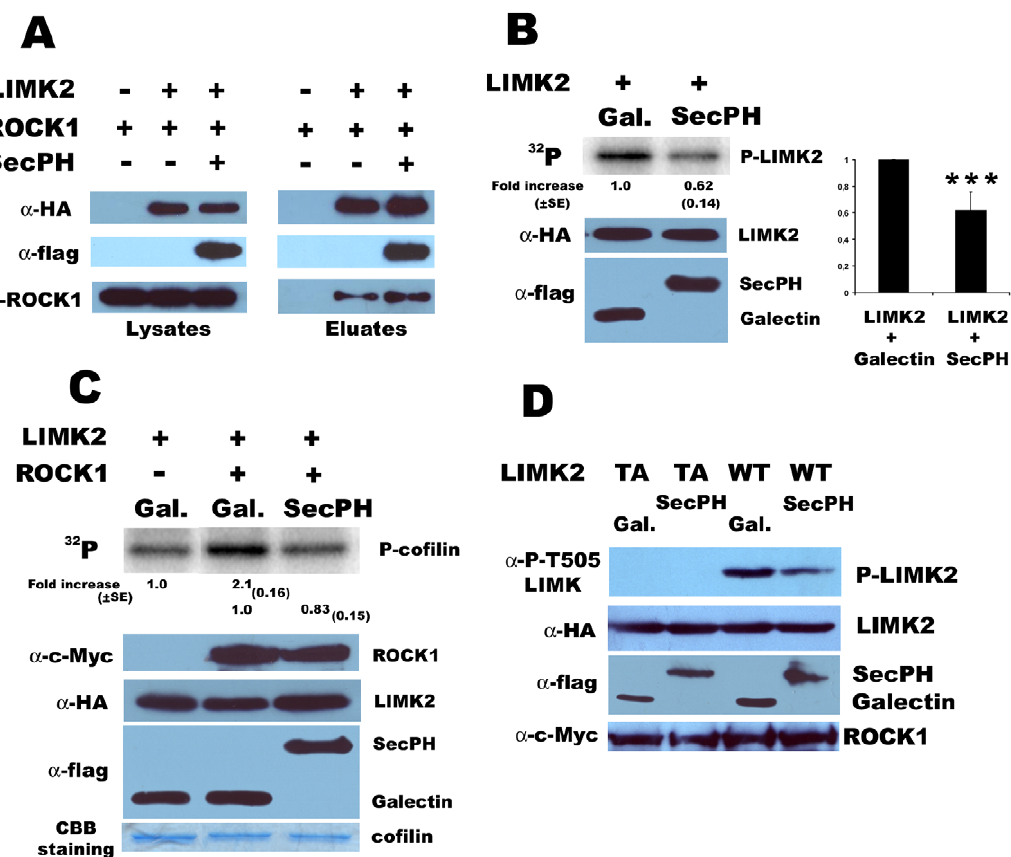
Figure 4. Mechanism of SecPH inhibition of LIMK2 kinase activity. A. SecPH does not prevent LIMK2 from interacting with ROCK1 . Cells were cotransfected with HA-LIMK2, ROCK1 and SecPH or its empty parental plasmid. Lysates and anti-HA immunoprecipitates were subjected to immunoblotting. B. SecPH affects LIMK2 phosphorylation. Same as Figure 2B. Statistical significance was determined relative to control using one-way ANOVA (*** p , 0.0001). C. Inhibition of LIMK2 cofilin phosphorylation by SecPH in the presence of ROCK1. Cells were cotransfected with ROCK1, LIMK2 and SecPH or Galectin-3 (a non-specific control protein). Immunoprecipitated HA-LIMK2 and GST-cofilin were used for the kinase assay. The kinase activity on cofilin of immunoprecipitated HA-LIMK2 from cells cotransfected with Galectin-3 was taken as 1.0. Each value represents the mean 6 SE (standard error) of four independent experiments. The HA-immunoprecipitates were also submitted to immunoblotting and to coomassie blue staining. Lysates were also submitted to flag-immunoblotting. D. SecPH affects LIMK2 T505 phosphorylation by ROCK1. Cells were cotransfected with either LIMK2-TA or LIMK2-WT and SecPH or Galectin-3 (a non-specific control protein). Lysates were subjected to immunoblotting. (Figure 4D). These results suggest that SecPH affects LIMK2- T505 phosphorylation by ROCK1.